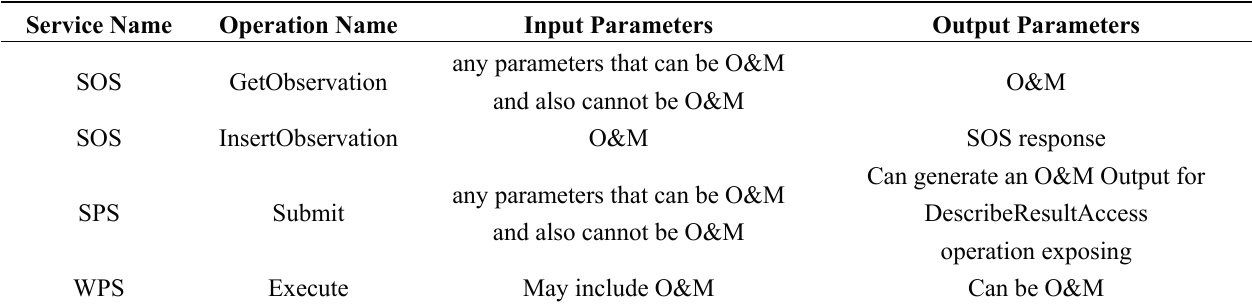
Table 1. Relationships between Sensor Web services and